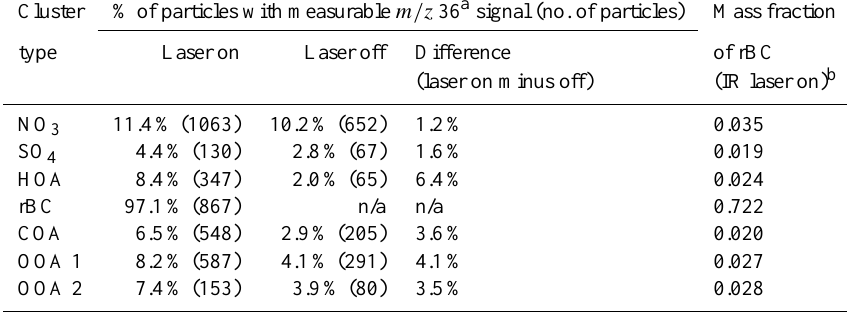
Table 2. Summary of the rBC contribution to each cluster. Cluster % of particles with measurable m/z 36 a signal (no. of particles) Mass fraction type Laser on Laser